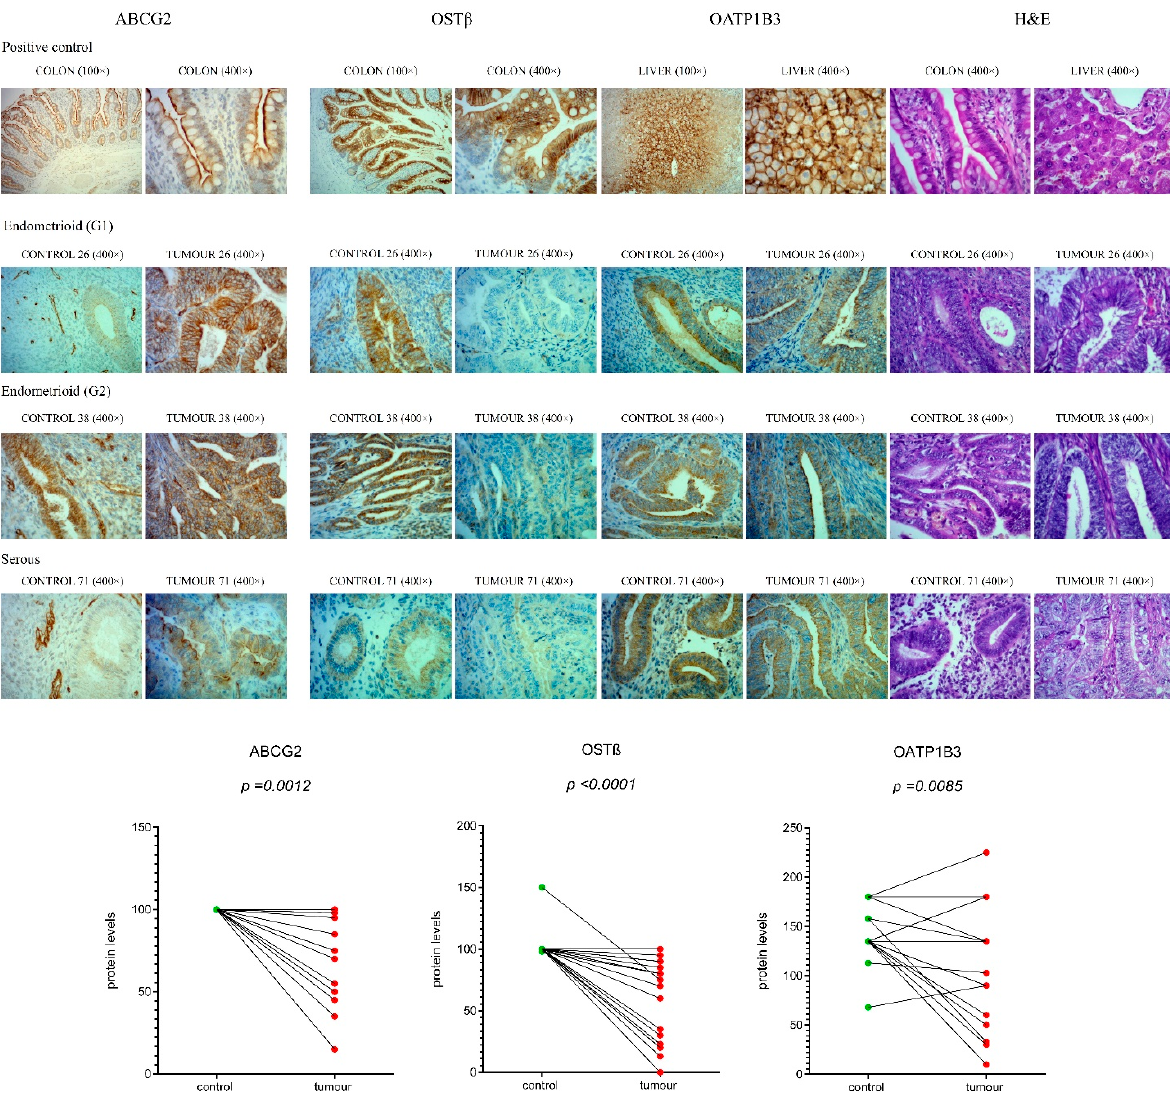
Figure 6. Immunohistochemical staining for ABCG2, OST β and OATP1B3 in EC and adjacent control endometrium. Representative control endometrium (C26, C38, C71), endometrioid grade 1 tumour (T26), endometrioid grade 2 tumour (T38), serous tumour (T71), colon and liver paraffin sections (positive controls), were stained with anti-ABCG2, anti-OST β and anti-OATP1B3 antibodies, and with haematoxylin and eosin (H&E) staining. Magnifications of 100× and 400× are shown. Protein levels of ABCG2, OST β and OATP1B3 in EC compared to adjacent control tissue ( n = 20) are shown as before-and-after graphs (paired t -test). The same trends in protein levels were also seen for immunohistochemical analysis of all 52 samples, paired and unpaired (figure not shown).